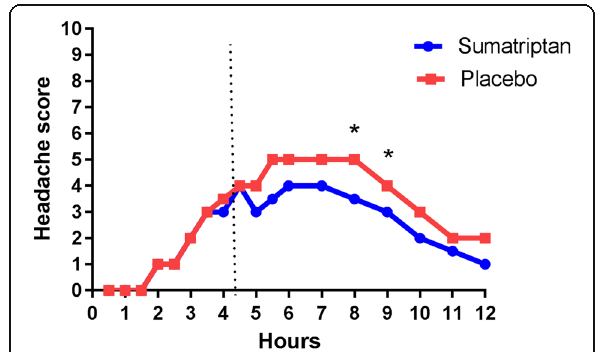
Fig. 2 Median headache score after cilostazol. Median headache score 0-12 h after cilostazol on the two treatment days. Median time to treatment was 4.5 h on the sumatriptan day and 4.25 h on the placebo day illustrated by the dotted line. The difference between the two treatment days is significant at 4 h ( p = 0.017) and 5 h ( p = 0.028) after treatment